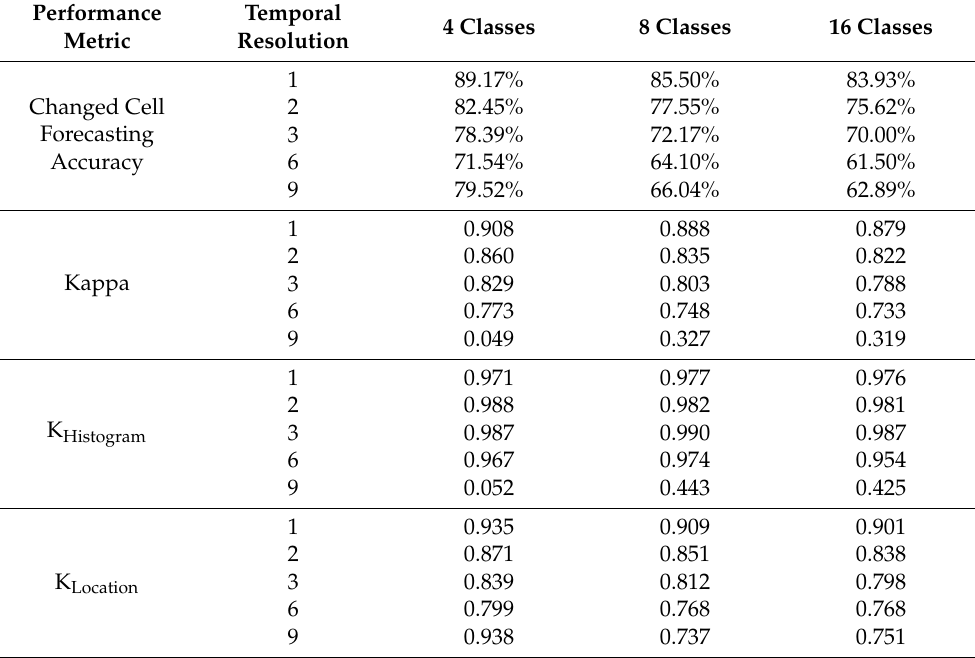
Table 11. Metrics obtained using the 19-year real-world LC datasets featuring 4, 8, and 16